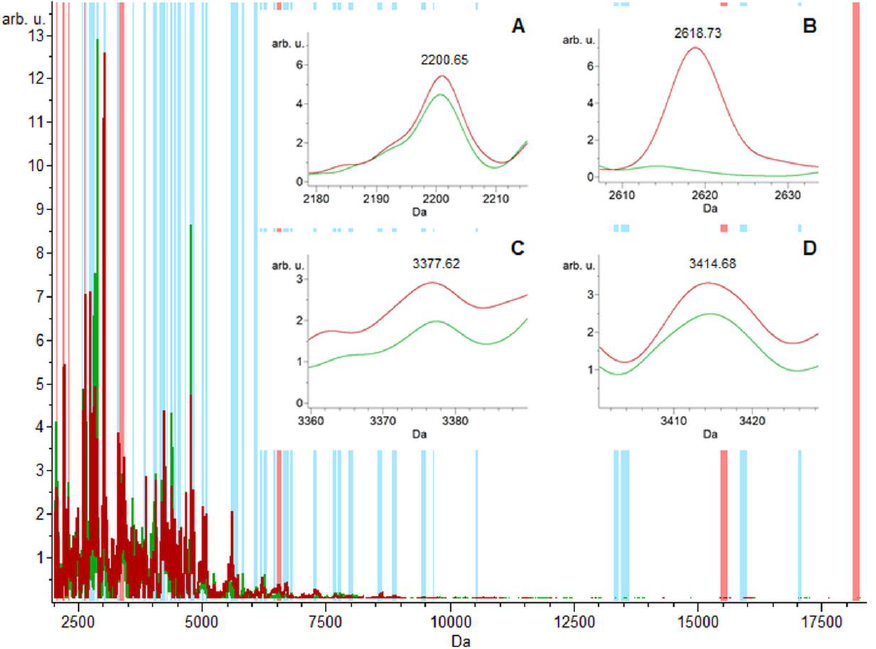
Figure 1. The location of discriminating peak masses, m / z 2050.8, 2200.6, 2291.0, 2618.7, 3343.6, 3377.6, 3414.6, 6525.5, 15,514.5, and 18,202.8, determined by the GA model with the highest recognition capability. ( A – D ) The zoomed-in total average spectra of several ions displaying differential expression levels in the groups; control and CIN3, depicted in red and green, respectively, of the urine samples.